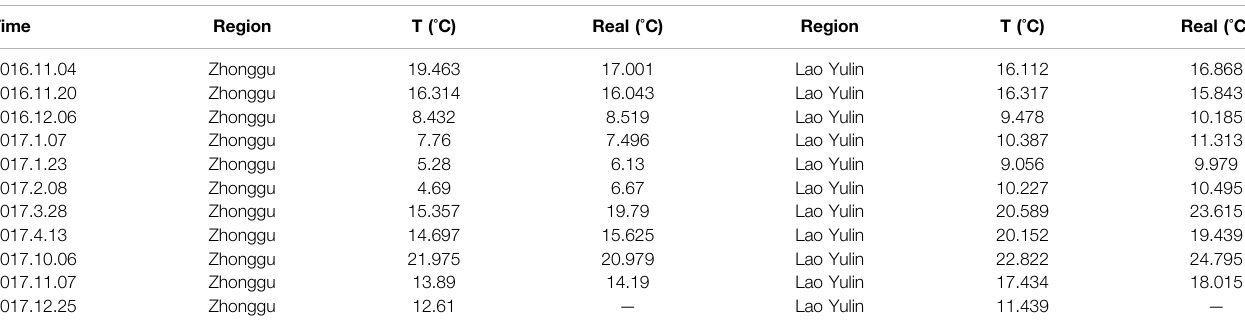
TABLE 4 | Statistics of RTE LST retrieval